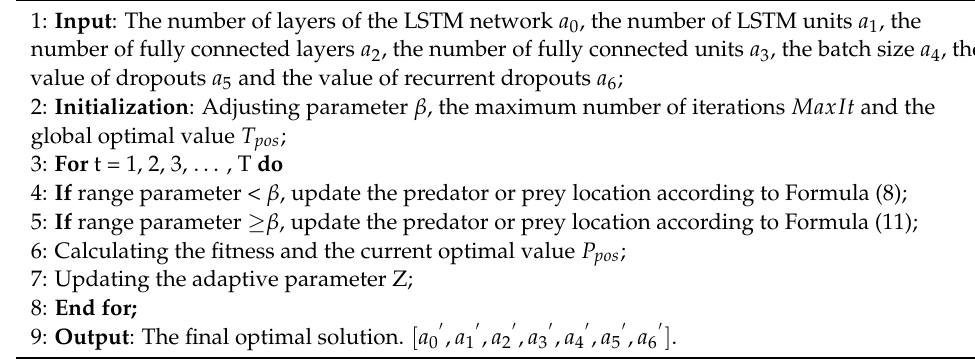
Algorithm 1: The process for the hyperparameters of the LSTM network structure optimized using the HPO